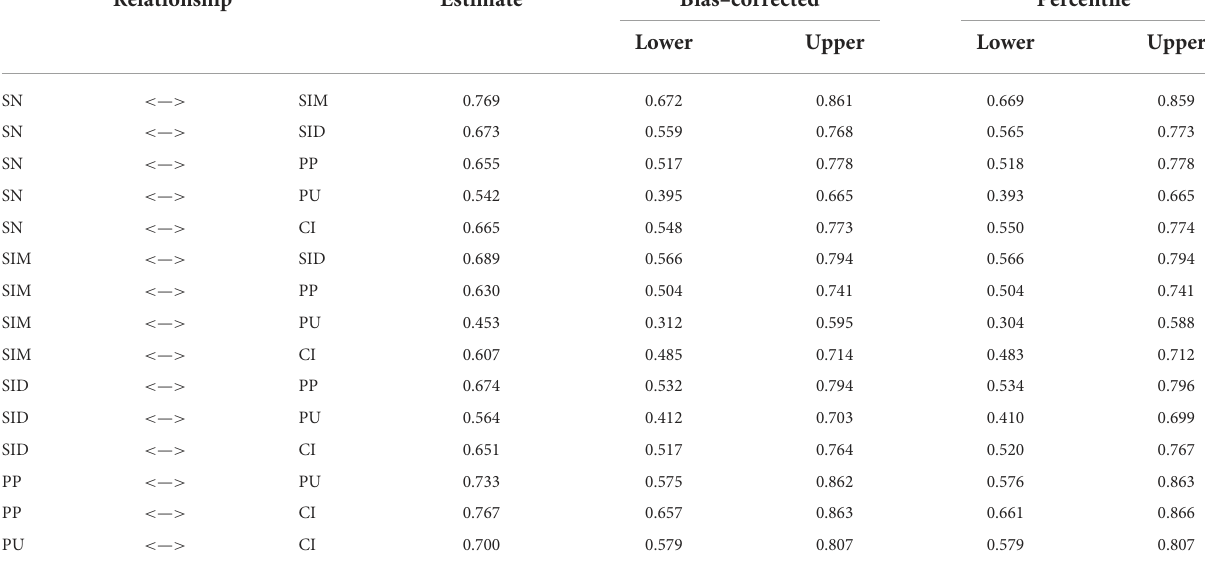
TABLE 5 Discriminant validity analysis